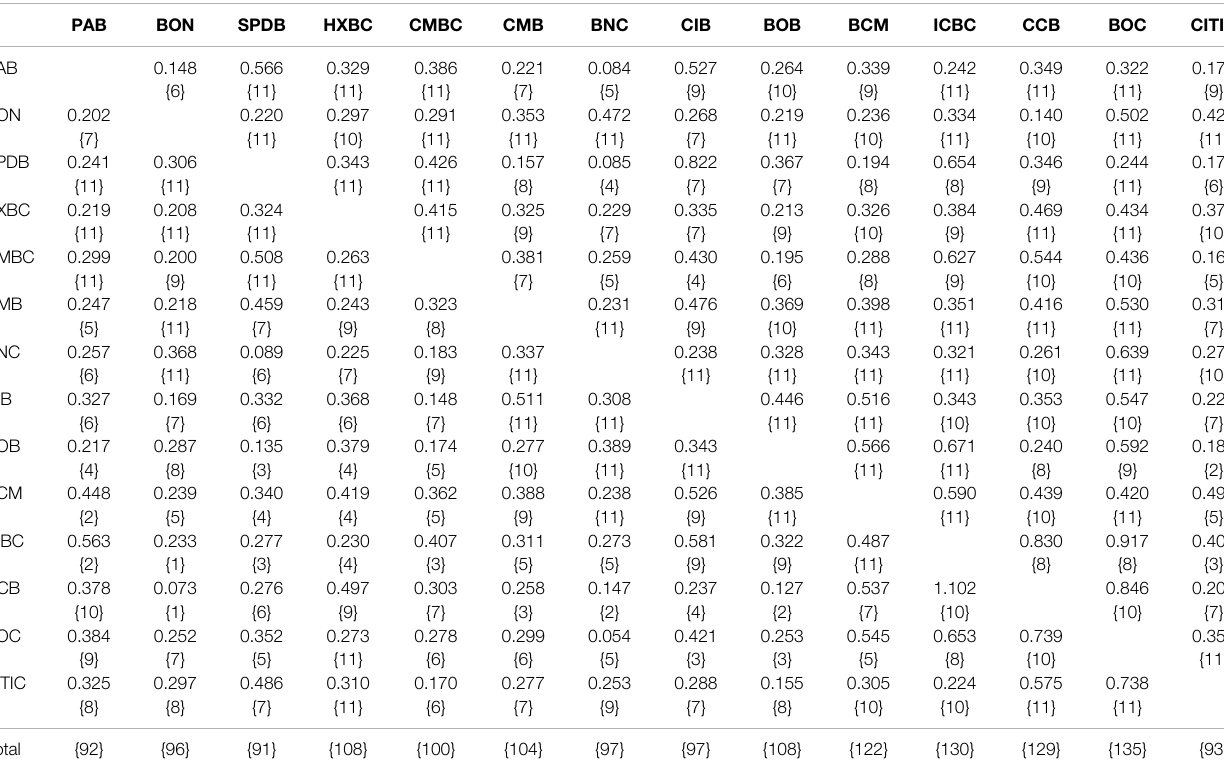
TABLE 7 | Statistics of characteristics of time-varying MDMC networks from 2008 to 2018. PAB PAB BON 0.202